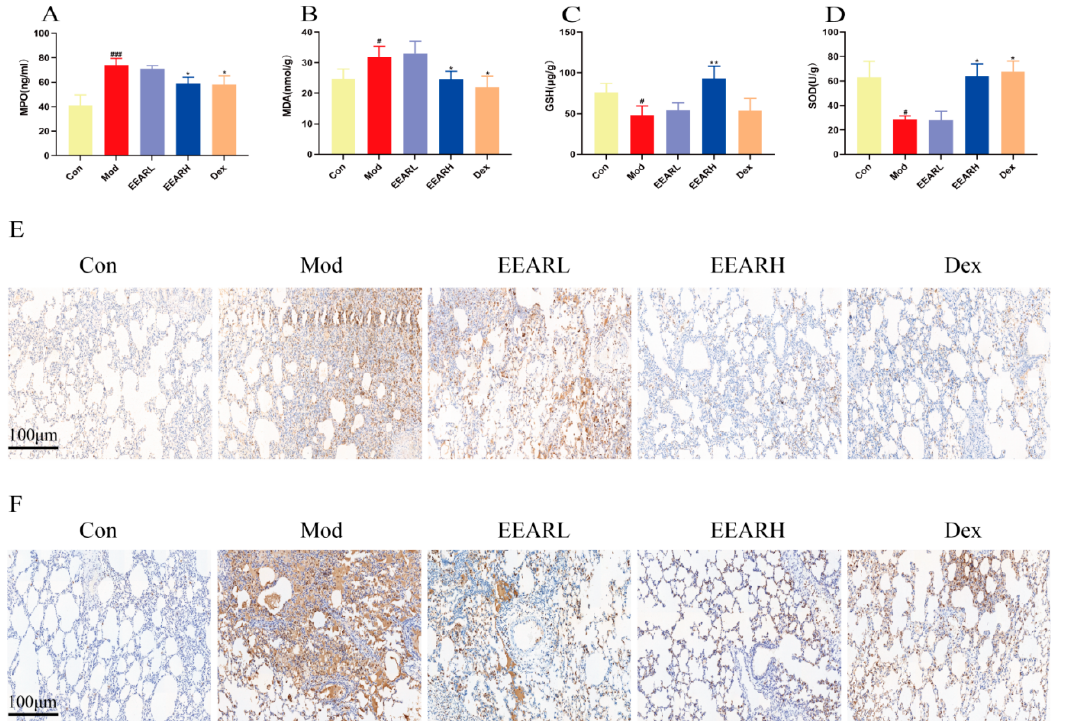
Figure 3. EEAR reduced neutrophil activation and oxidative stress levels in the lungs of rats with ALI. ( A ) MPO activity in the BAFL of rats ( n = 10). ( B ) MDA activity in rat lung tissue ( n = 10). ( C ) GSH activity in the lung tissue of rats ( n = 10). ( D ) SOD activity in the lung tissue of rats ( n = 10). ( E ) Immunohistochemical staining of MPO in lung tissue. ( F ) Immunohistochemistry showing neutrophils in lung tissue. Values are expressed as means ± SEM. ### p < 0.001 vs. Control; # p < 0.05 vs. Control; ** p < 0.01 vs. Model; * p < 0.05 vs. Model.